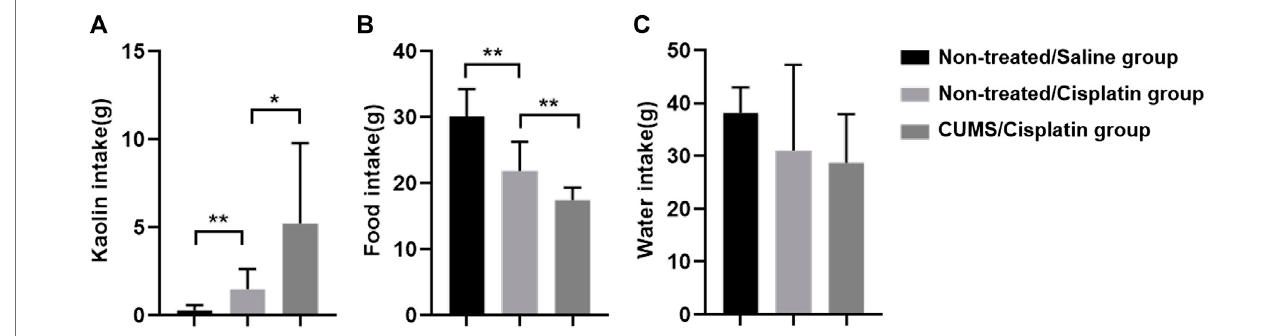
FIGURE2| Chronicstresspretreatmentenhancedcisplatin(6 mg/kg)-inducedanorexiaandpicabehaviorinrats( n =10/group). (A) Kaolinintake. (B) Foodintake. (C) Water intake. * p < 0.05 and ** p < 0.01(statistical comparisons in the inter-groups were performed using one-way analysis of variance